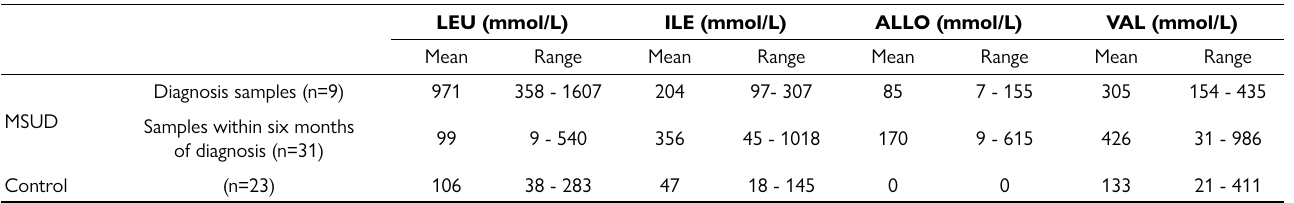
Table 2. Comparison of branched-chain amino acids (BCCAs) levels quantified by liquid-chromatography mass spectrometry (LC-MSMS) in dried blood spot samples of MSUD patients at diagnosis and follow-up with control newborn samples.